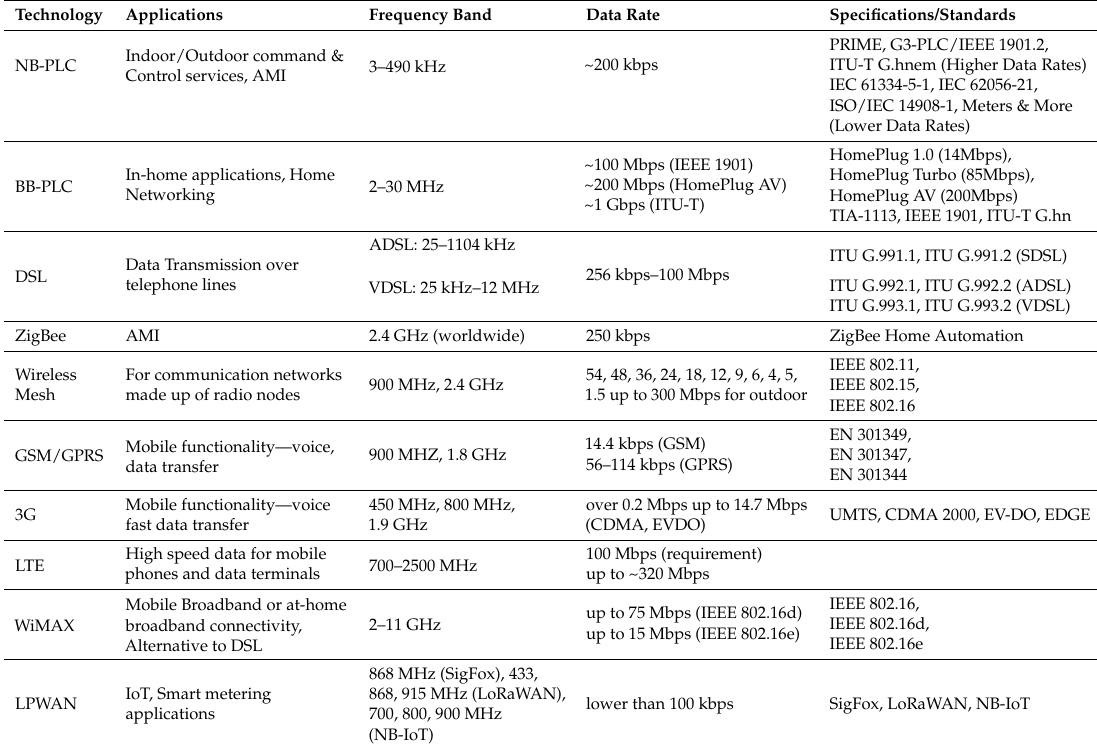
Table 1. Smart grid Communication